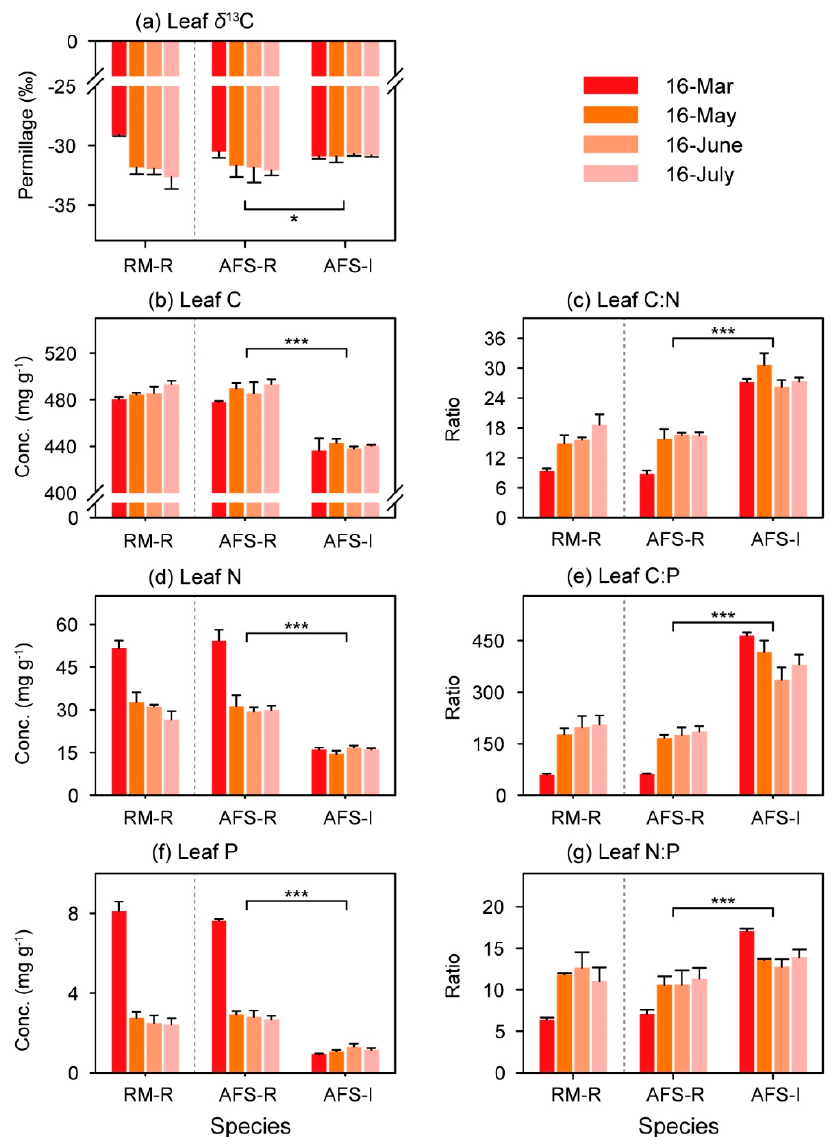
Figure 4. ( a ) Leaf δ 13 C; ( b – d ) leaf C, N, and P concentrations’ and ( e – g ) leaf C / N, C / P, and N / P ratios of each plant species at each site. Data are expressed as the mean ± SD. * p < 0.05, ** p < 0.01, *** p < 0.001. See Figure 3 for abbreviations.